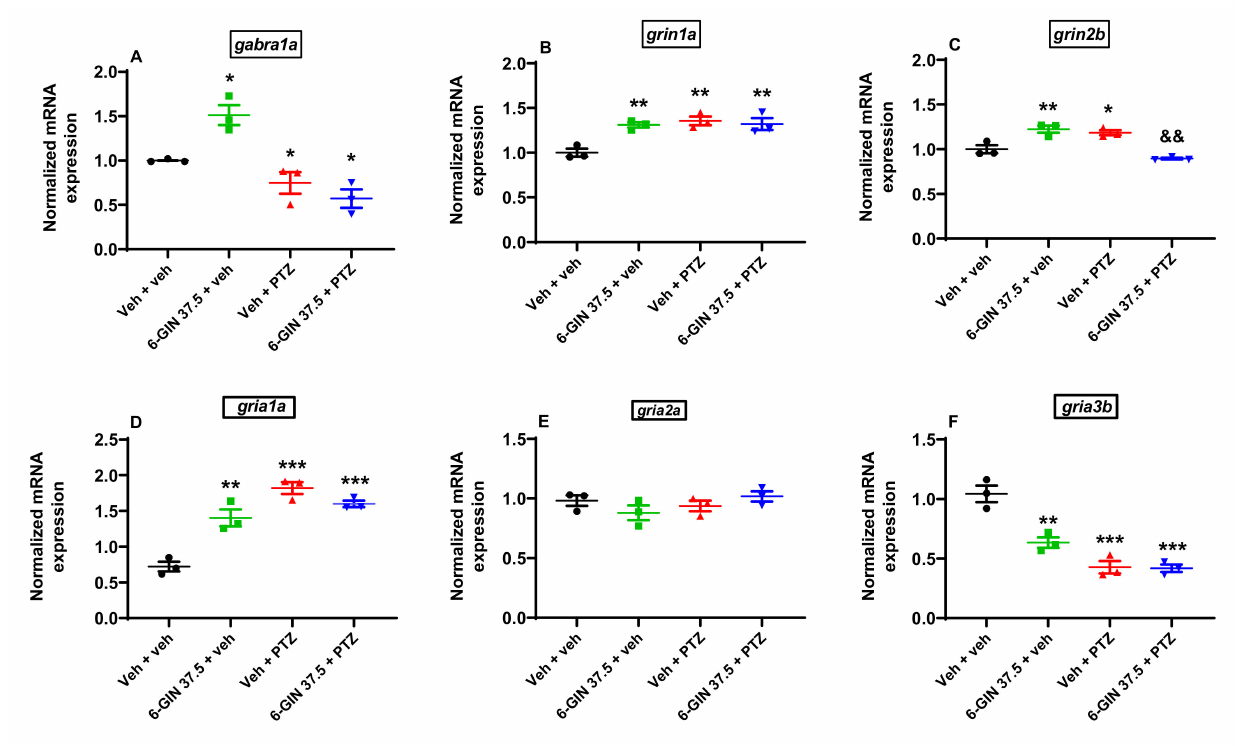
Figure 7. The effect of 6-GIN on ( A ) gabra1a , ( B ) grin1a , ( C ) grin2b, ( D ) gria1a, ( E ) gria2a , and ( F ) gria3b mRNA expression in PTZ-treated zebrafish larvae. After a 24 h incubation in 6-GIN (37.5 µ M), zebrafish larvae were exposed to PTZ (20 mM) for 90 min. Next, zebrafish larvae were collected in a pool of n = 10/sample. mRNA levels were normalized against gapdh. Data were analyzed using one-way ANOVA with Tukey’s post hoc test. Data are depicted as a mean ± SEM ( n = 3/group). *** p < 0.01, ** p < 0.01, * p < 0.05 vs. Veh + veh; && p < 0.01 vs. Veh + PTZ. 6-GIN—6-gingerol, PTZ—pentylenetetrazole, Veh—vehicle. n —refers to the total number of